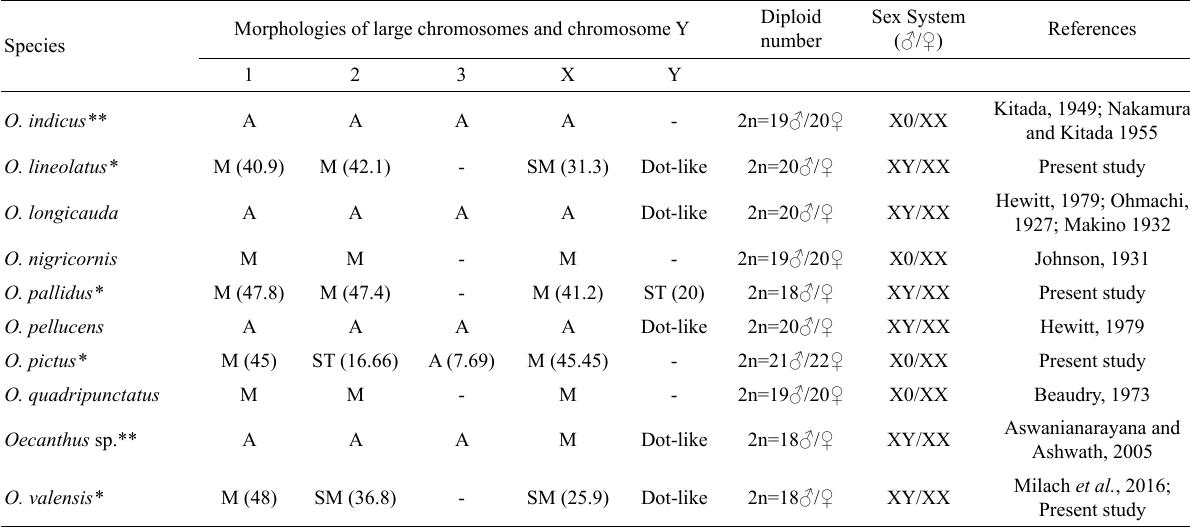
Table 4 – Available literature information: new results of karyotypes in Oecanthus , describing the diploid number, sex system, and morphologies for large chromosomes, the sexual X and Y.